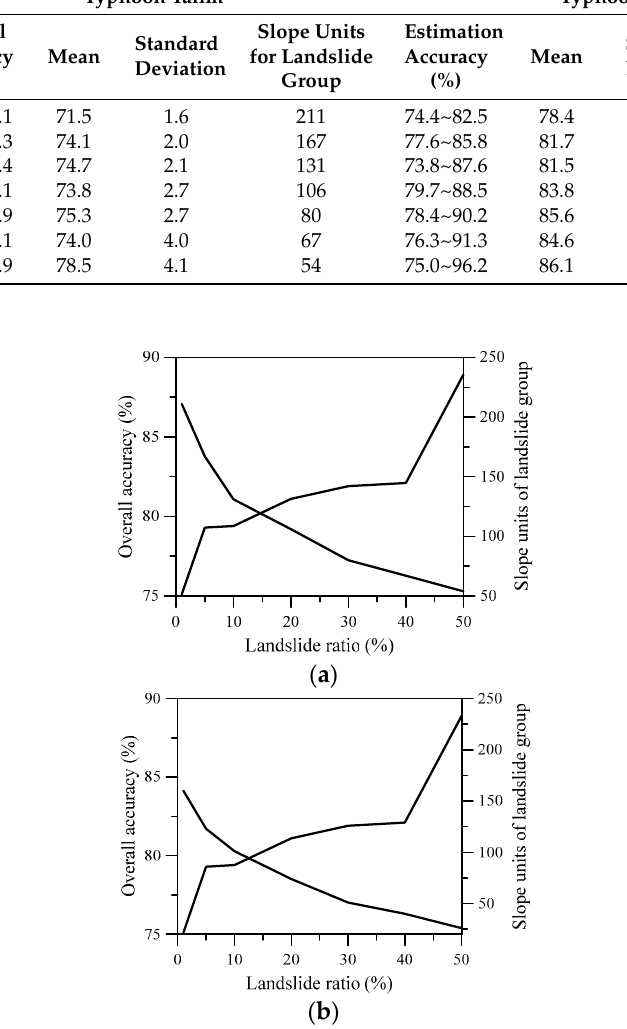
Figure 5. Variations of mean accuracy with slope units of landslide group and landslide ratio: ( a ) Typhoon Talim and ( b ) Typhoon Jangmi. Table 2. List of the thresholds and the statistics of corresponding estimation accuracy. Landslide Ratio (%)